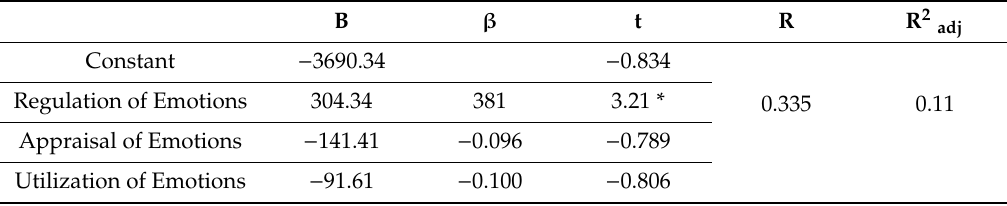
Table 2. The ability of the trait emotional intelligence to predict LF power during recovery. B β